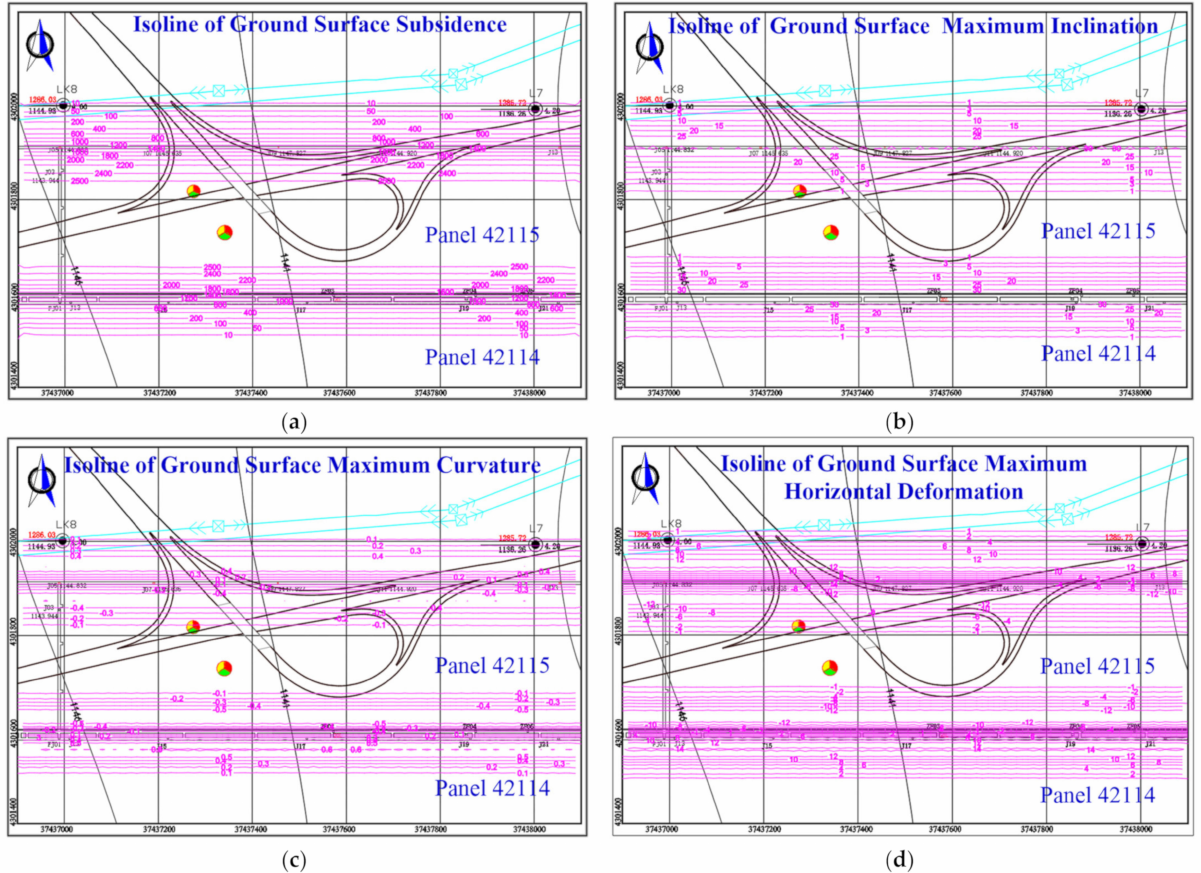
Figure 13. Prediction results of surface deformation after 42,115 working face normal mining. ( a ) Ground surface subsidence; ( b ) Ground surface inclination; ( c ) Ground surface curvature; ( d ) Ground surface horizontal